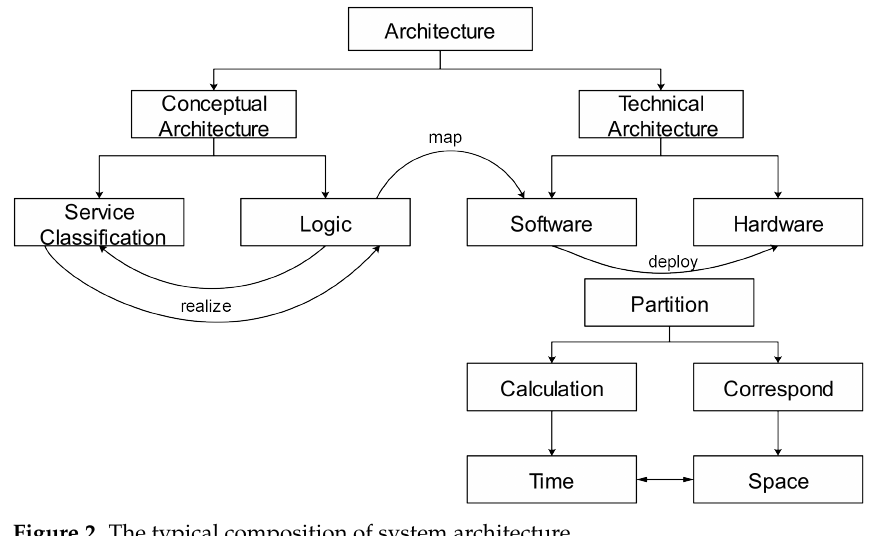
Figure 2. The typical composition of system architecture.